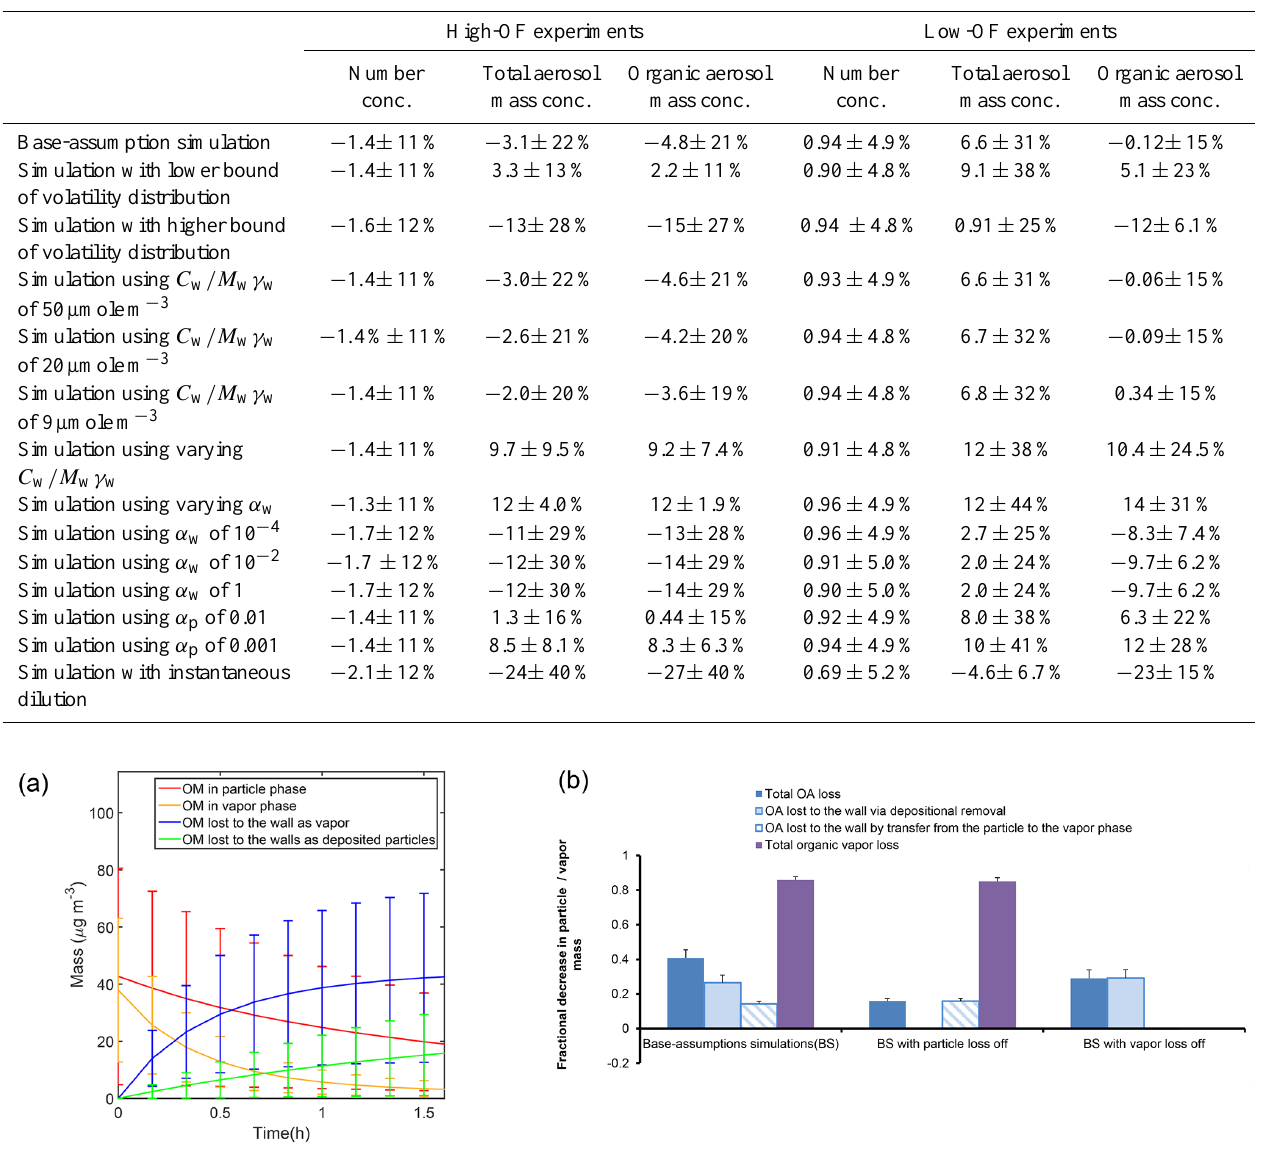
Figure 3. (a) Time evolution of organic mass (OM) in the particle and vapor phases, and vapor- and particle-phase losses to the chamber walls averaged over the 18 simulations with base assumptions (in units of µgm − 3 ; the mass of particles and vapor on the wall has been normalized by the volume of the bag); (b) organic species budgets for the base simulation and two sensitivity studies. The vertical bars show the fraction of the initial assumed total organic aerosol (OA) that is removed from the chamber volume during the 75min simulation period (blue); lost to the walls via depositional removal of particles (light blue); transferred from the particle phase to the vapor phase (blue hatched). The blue bars have been normalized by the initial particulate organic mass. The purple bars show the total fractional organic vapor that is removed from the chamber during the simulation period. The error bars represent 1 standard deviation in the simulations of the 18 burns and represent burn-to-burn